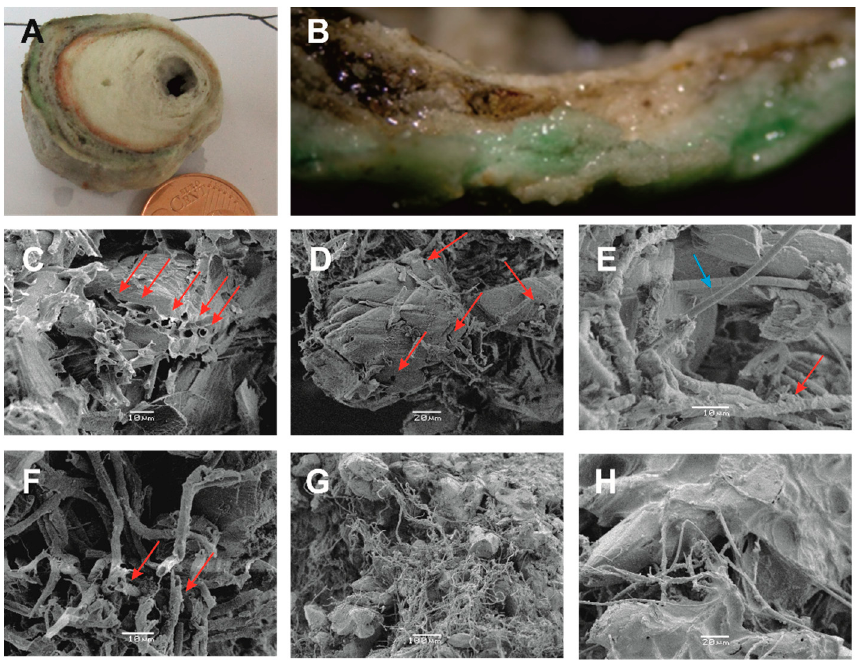
Figure 8. Biomineralizing processes by Cyanobacteria under SEM. ( A ) Vertical cut section surface of stalactite. ( B ) Detailed view of the outer periphery of stalactite, presenting fluvial crust with char- acteristic zoning and filaments of the endolithic Leptolyngbya perforans and L. ercegoviccii destroying the stalactite; whereas the upper zone is covered by granular epilithic species such as Chroococcus lithophilus . ( C , D ) Calcite crystals with distinct holes and dig channels are occupied by filamentous Cyanobacteria. ( E ) Filamentous Cyanobacteria of the endolithic Leptolyngbya perforans are coming out of calcite crystal (blue arrow) and calcified sheaths of Cyanobacteria filaments (red arrow). ( F ) Calcified sheaths of Cyanobacteria filaments by micritic calcium carbonate crystals. ( G ) Retention of calcium carbonate crystals by filamentous Cyanobacteria. ( H ) EPS along with filaments.